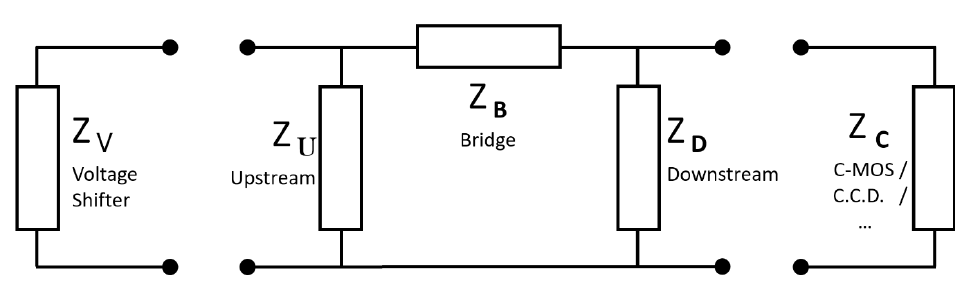
Figure 3. Pi Filter Architecture and Conventional